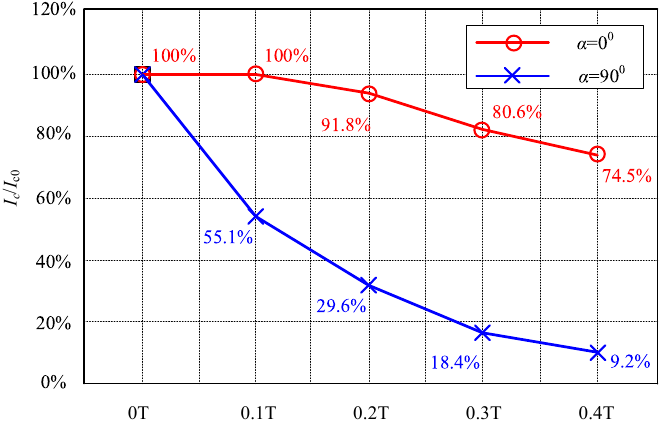
Figure 8. Anisotropy of critical current in applied magnetic field at 77 K with different α .